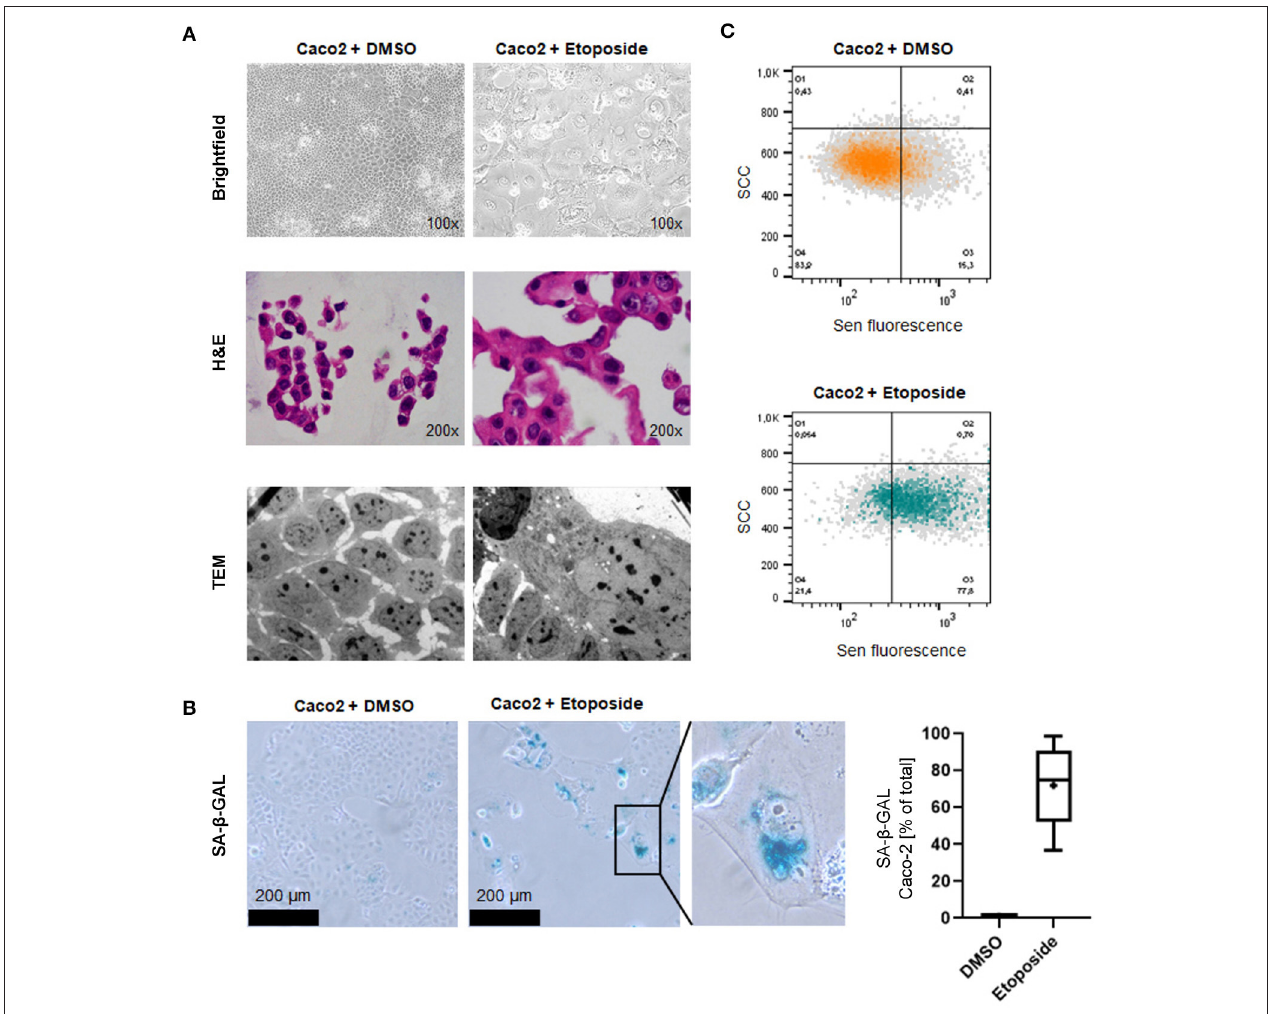
FIGURE 1 | Induction of cellular senescence in vitro by Etoposide treatment. (A) Morphological appearance of Etoposide (Eto)-treated and control (DMSO) Caco2 cells using brightfield microscopy (upper panel), normal H&E-stained sections of cytoblocks (middle panel) and TEM (lower panel). Senescent cells adopt a characteristic “fried egg” morphology, including an enlarged shape and nucleus. Cytoplasmatic vacuolation is apparent. (B) Increased senescence SA- β -GAL staining indicates senescence induction. SA- β -GAL-positive cells were counted after DMSO and Etoposide-treatment. (C) FACS analysis confirms senescence induction in Etoposide-treated